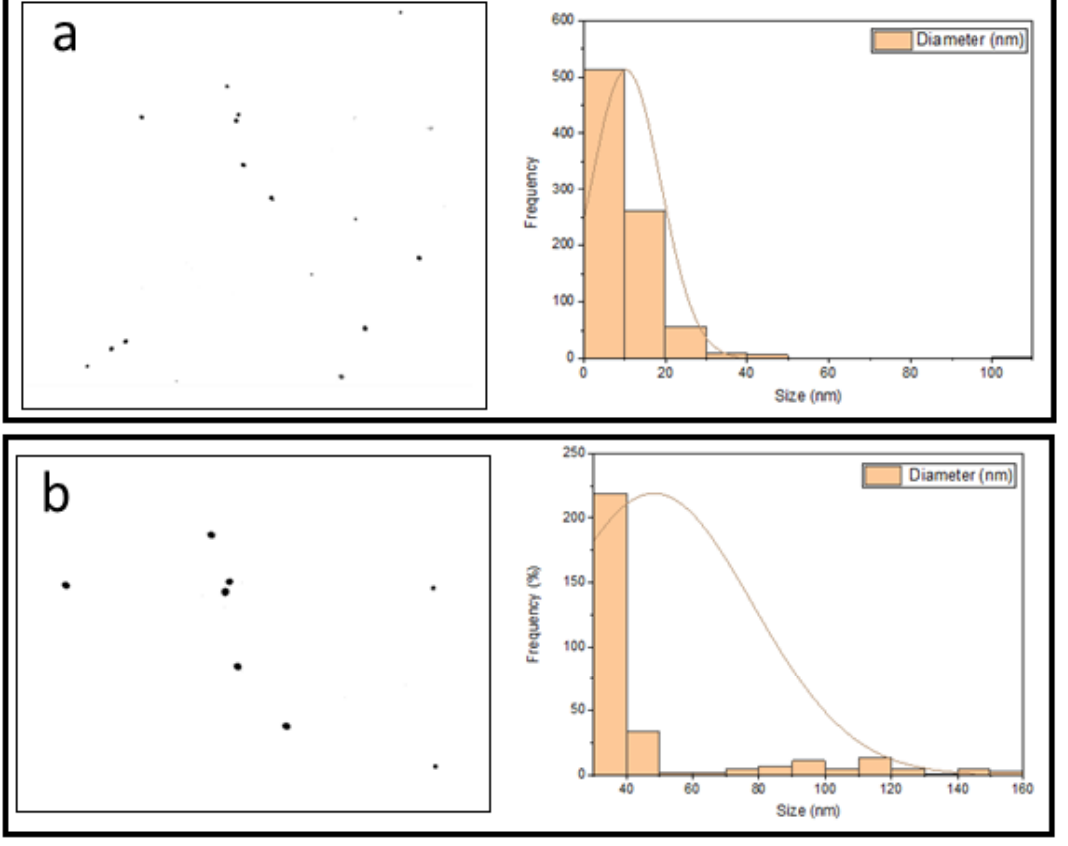
Figure 7 . SEM images of the GNPs prepared at various HAuCl 4 Concentration. ( a ) at 0.1 Mm (left hand side), ( b ) at 2 mM (left hand side), Histogram of percent frequency distribution of gold nanoparticles (right hand side).